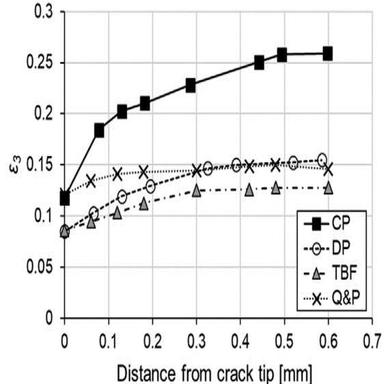
True thickness strain as a function of the distance from the crack tip.